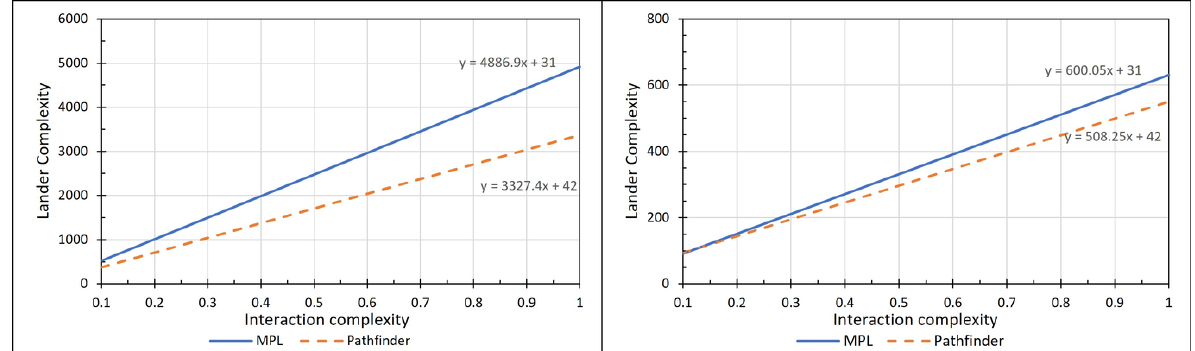
Figure 7. Impact of the interaction complexity value, β ij , to the lander complexity with the SysML Complexity metric ( left ) and the DSM Complexity metric ( right ) (please note the difference in scale between the two